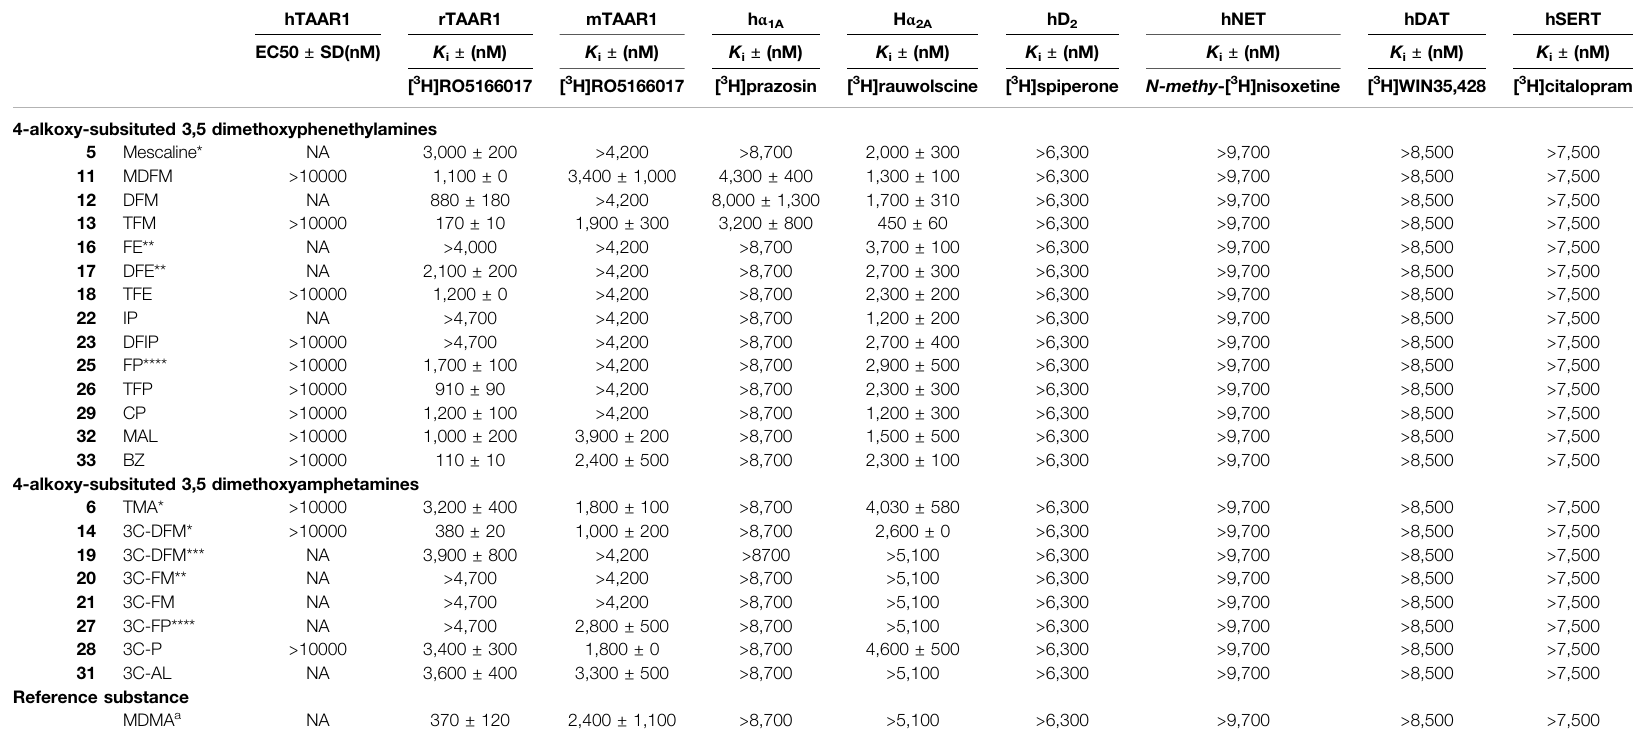
TABLE 2 | Non-serotonergic receptor and transporter binding af fi nities of 4-alkoxy-subsituted 3,5-dimethoxyphenethylamines and amphetamines.